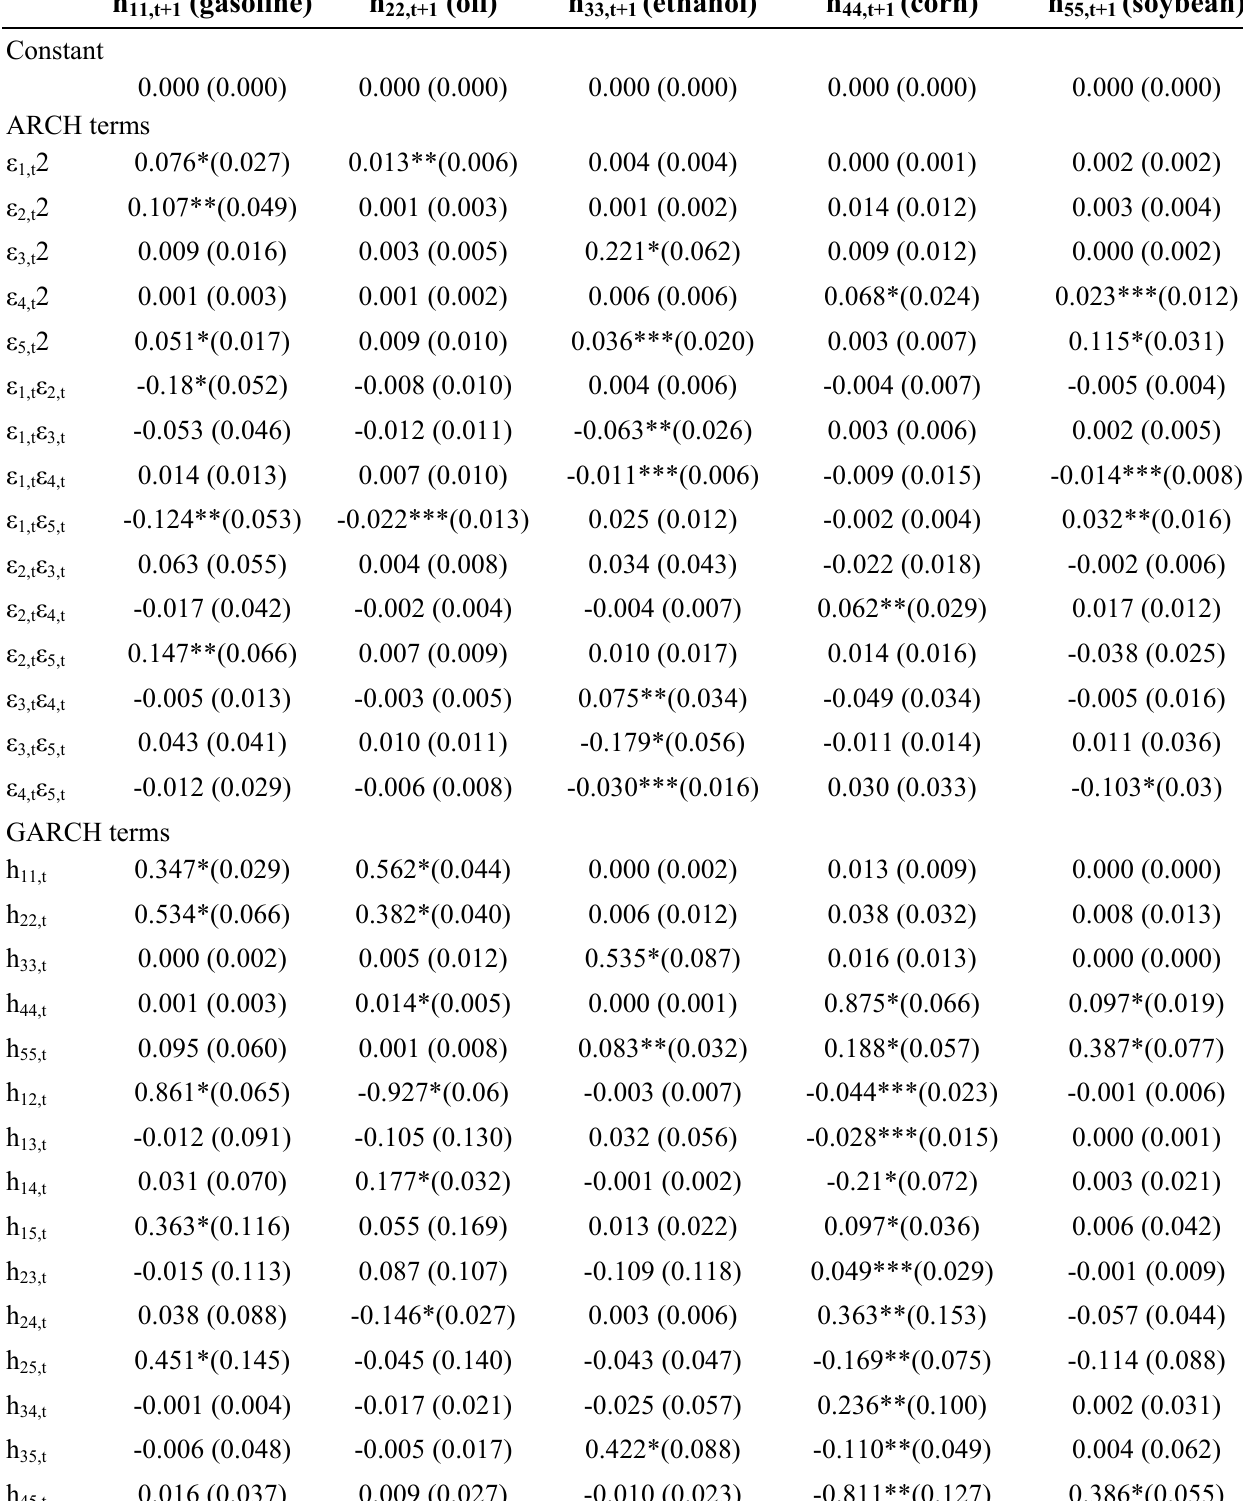
Table A6. MGARCH(1,1) Results for the Ethanol Boom